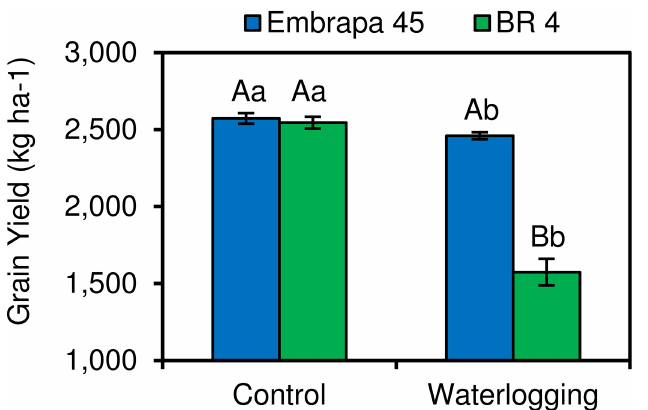
Fig 1. Grain yields of two soybean cultivars (flood-tolerant Embrapa 45 and flood-sensitive BR 4) under two moisture regimes in the soil. Control indicateswell-watered conditions (70% available water in the soil). n = 4, except for BR 4 under waterlogging(n = 3). Each biological repetitionconsisted of 75 plants, from which grain yield were convertedto 200,000plants per hectare. Means values ( ± S.E.M.) followedby different capital letters betweencultivars under same soil condition,and lowercase letters betweensoil conditions for same cultivar, significantly differ accordingto Tukey test 5%. https://doi.org/10.1371/journal.pone.0187920.g001 were more prevalent deeper into stress conditions [27]. In contrast to our findings in soybean data, where DRGs number decreased after 28h, DRGs remained after 168h of waterlogging in roots of flood-tolerant gray poplar ( Populus × canescens ) [28]. Even so, Embrapa 45 showed